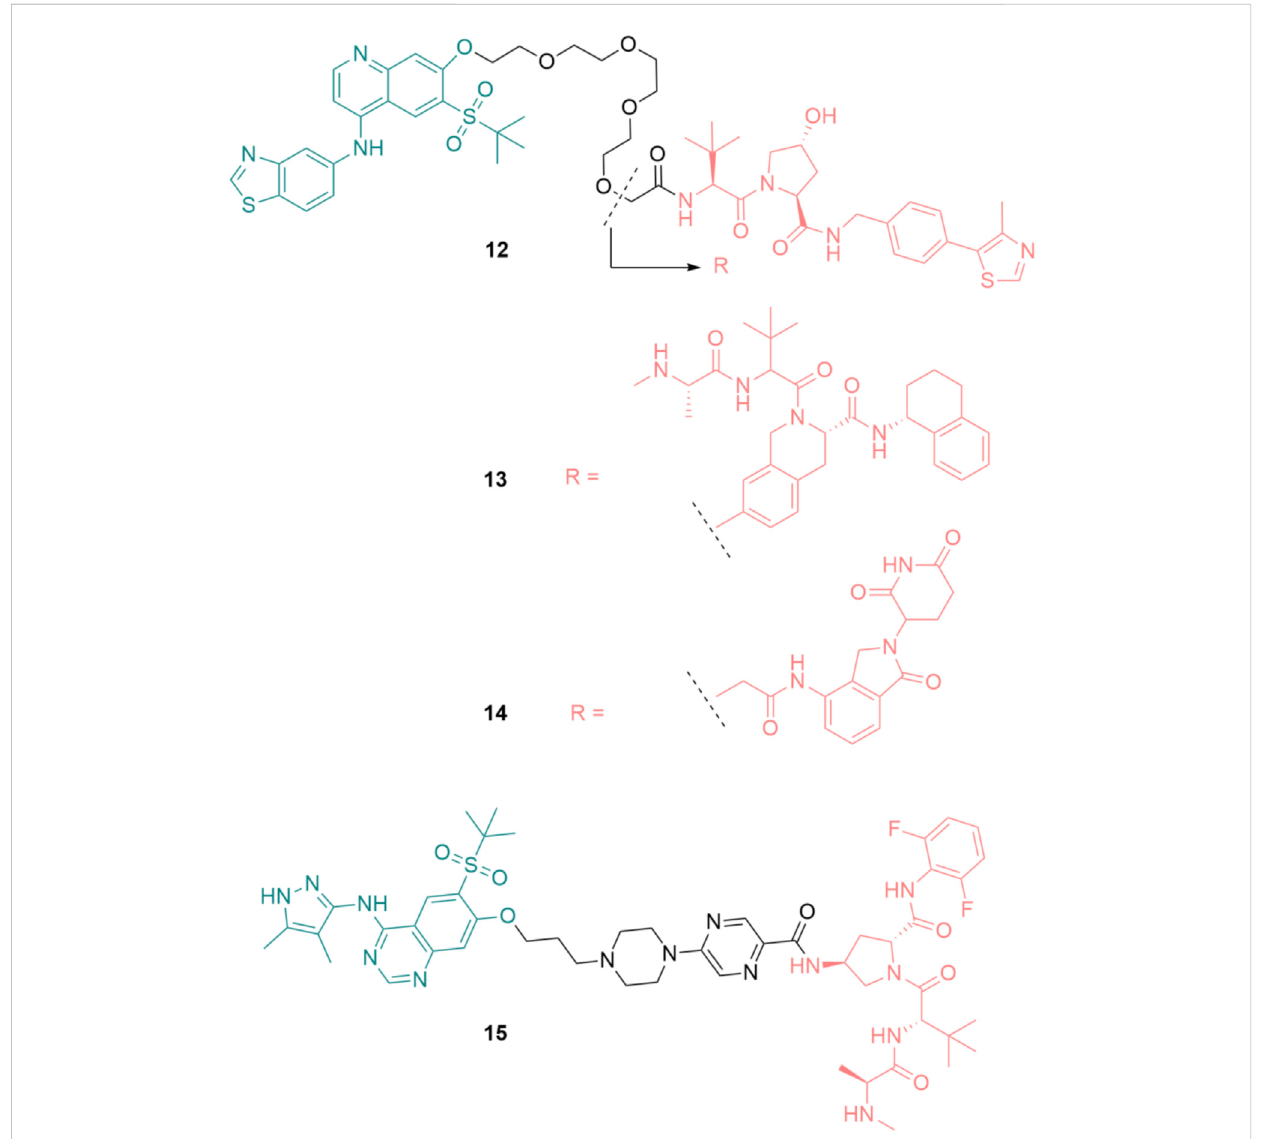
Structures of RIPK2 PROTACs. RIPK2 binders are highlighted in green. E3 ligase binders are highlighted in